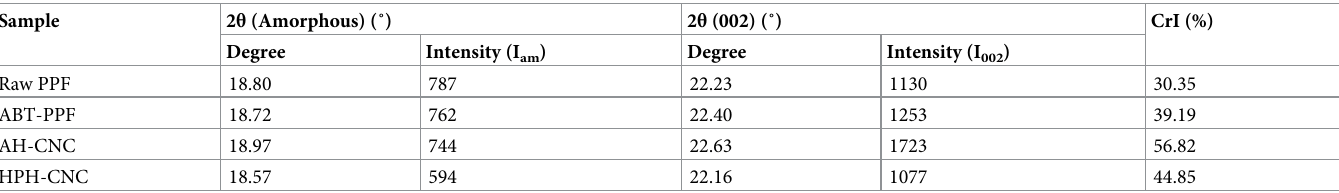
Table 3. Crystallinity index of Raw PPF, ABT-PPF, AH-CNC and HPH-CNC.